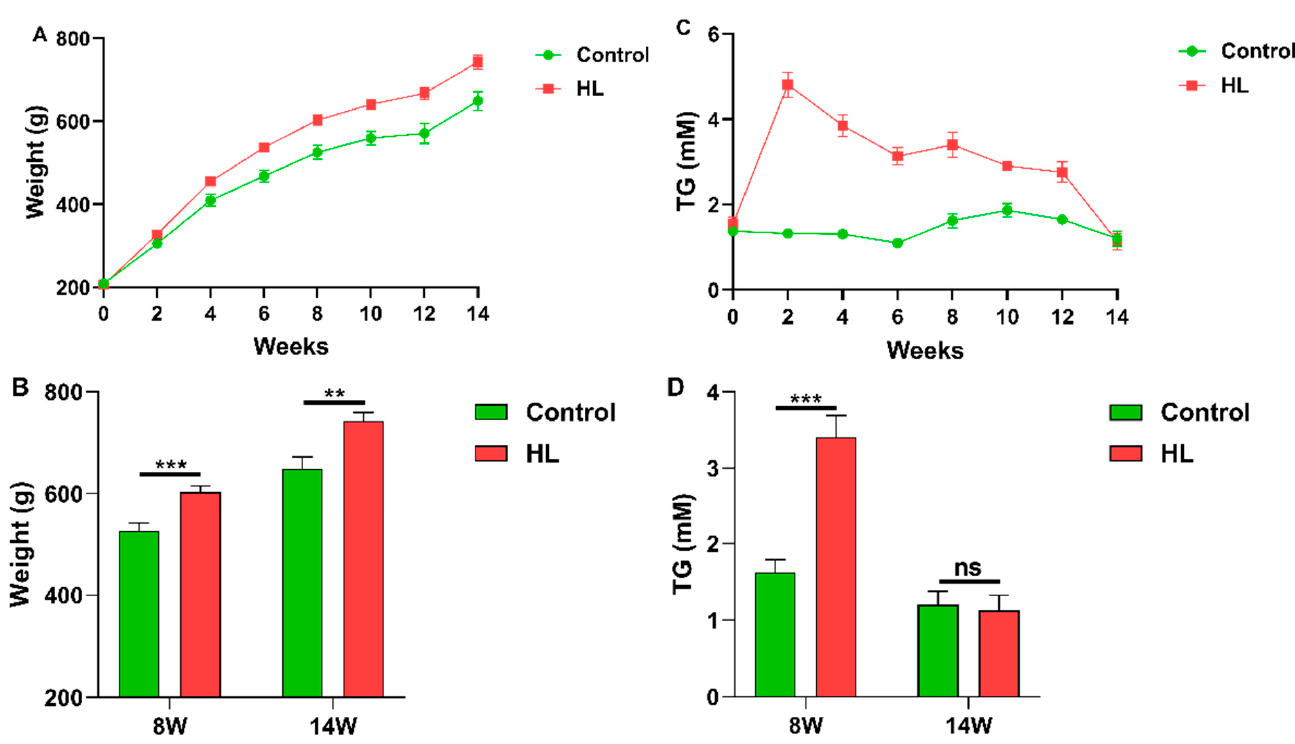
Figure 2. Weight and blood TG in the rat. ( A ) Change in weight over time. ( B ) The weight difference between the control and HL groups at 8 W (8 weeks) and 14 W (14 weeks). ( C ) Change in blood TG with time. ( D ) The blood TG difference between control and HL groups at 8 W (8 weeks) and 14 W (14 weeks). ** p < 0.01; *** p < 0.001; ns, no significance. Green lines and columns denote the control; red lines and columns denote the HL. n = 8; the sample repeat for each group was eight